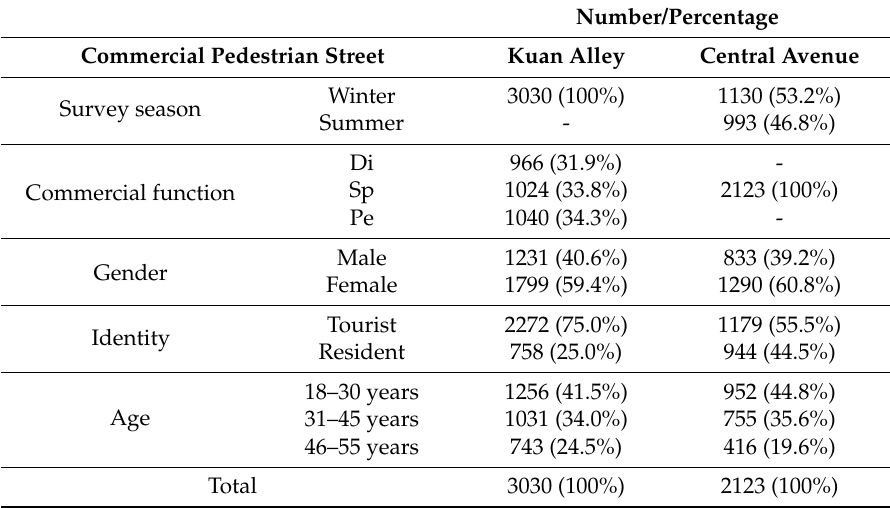
Table 2. The fundamentals of the state of the investigation